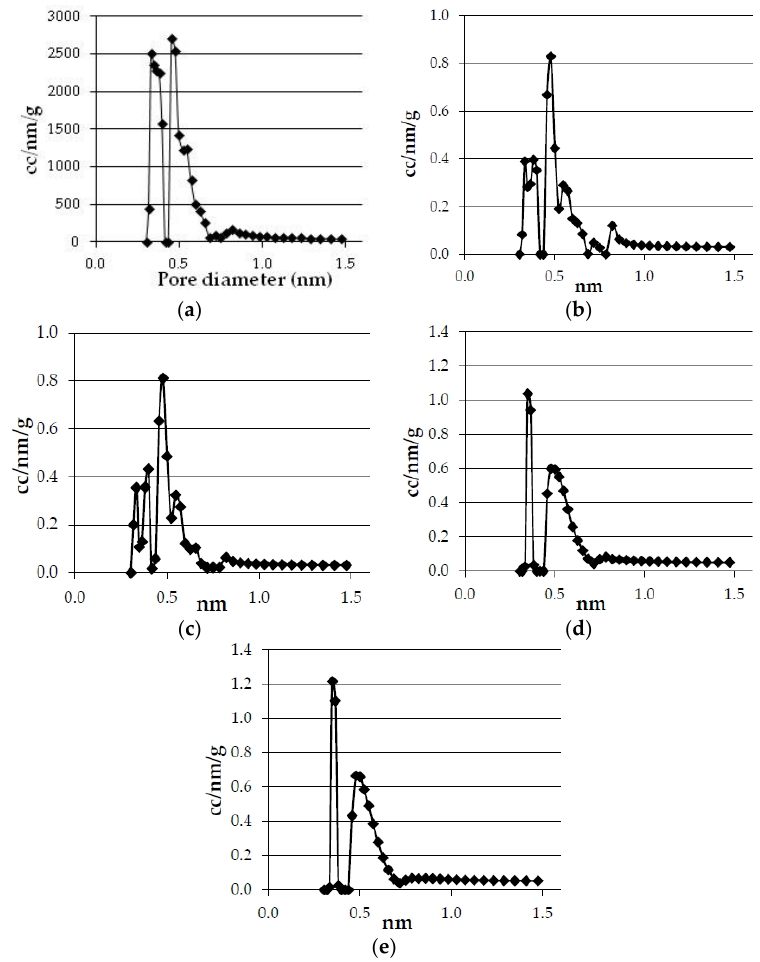
Figure 4. Effect of heating rate in pore size distribution of the bioreducers obtained at 750 °C from the olives and eucalyptus samples. ( a ) Olives 20 °C ∙ min − 1 ; ( b ) Olives 15 °C ∙ min − 1 ; ( c ) Olives 3 °C ∙ min − 1 ;